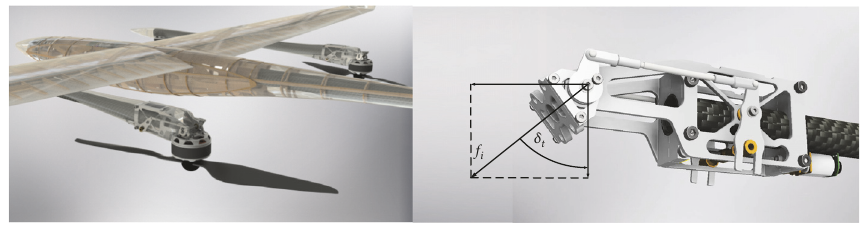
Figure 5: Tilt mechanism.